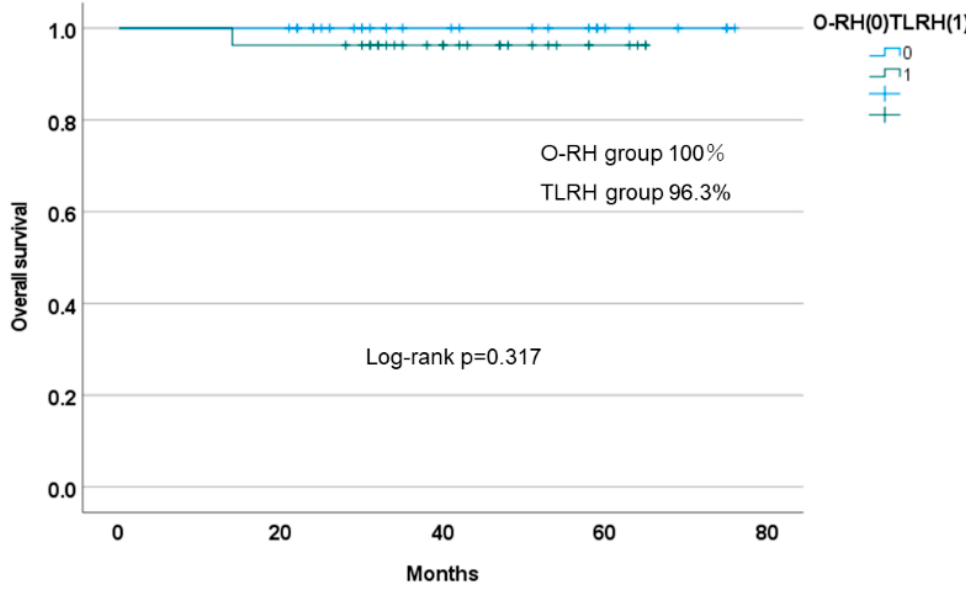
Figure 3. Kaplan–Meier curve for overall survival in propensity score-matched patients (TLRH vs. O-RH). O-RH: open-abdominal radical hysterectomy; TLRH: total laparoscopic hysterectomy.